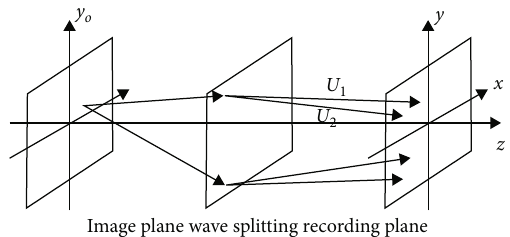
Figure 6: Schematic diagrams of the incoherent digital holographic recording